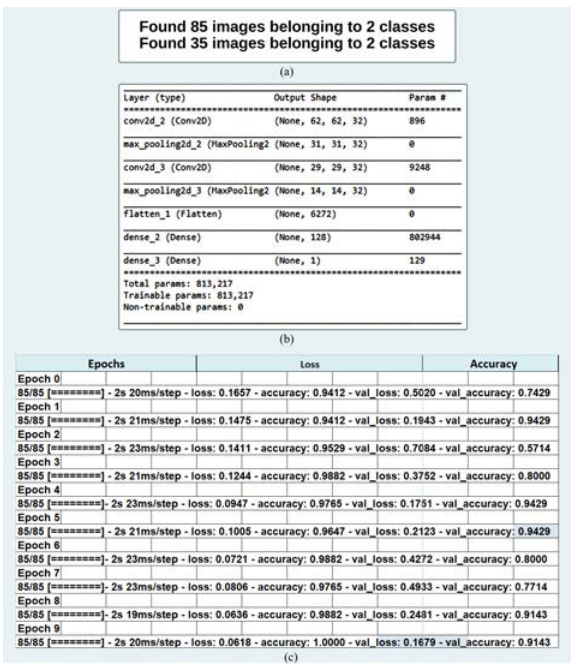
Fig. 14 CNN model results.